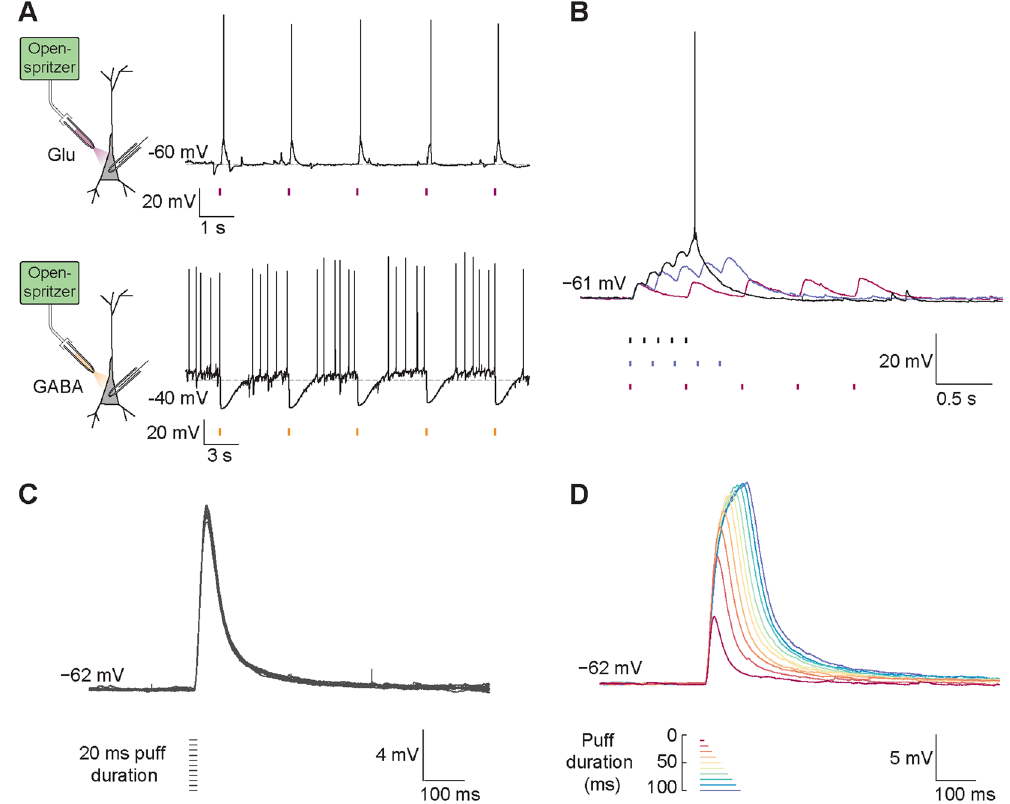
Figure 3. Openspritzer delivers neurotransmitters with millisecond precision to control neural activity. ( A ) Whole-cell patch clamp recordings in current clamp mode were performed on CA3 hippocampal pyramidal cells. Openspritzer was used to deliver 20 ms puffs of either glutamate (100 μ M), top, magenta, or GABA (100 μ M), bottom, orange, to the soma of recorded cells. A separate micropipette was used for each neurotransmitter. Membrane voltage recordings demonstrate that Openspritzer-applied glutamate reliably evoked EPSPs and action potentials (top). Similarly, GABA application reliably suppressed action potential activity elicited by somatic current injection (bottom). ( B ) In the same cell as in the top panel of ‘A’, driving pressure was adjusted so that a single 20 ms glutamate puff was insufficient to trigger an action potential. 2, 5 and 10 Hz application (magenta, blue and black) of 20 ms glutamate puffs resulted in distinguishable trains of EPSPs. The EPSPs in response to the 10 Hz train summated sufficiently to generate an action potential. ( C ) In separate recordings with a different micropipette and in the presence of 1 μ M tetrodotoxin to reduce synaptic noise, 10 sweeps including 20 ms glutamate puffs applied after 500 ms produced almost identical EPSPs demonstrating the precise timing of Openspritzer and highly conserved puff volumes. Traces were not rise- time or peak aligned. ( D ) Puffs of increasing duration from 10 to 100 ms in 10 ms steps resulted in EPSPs of increasing duration and